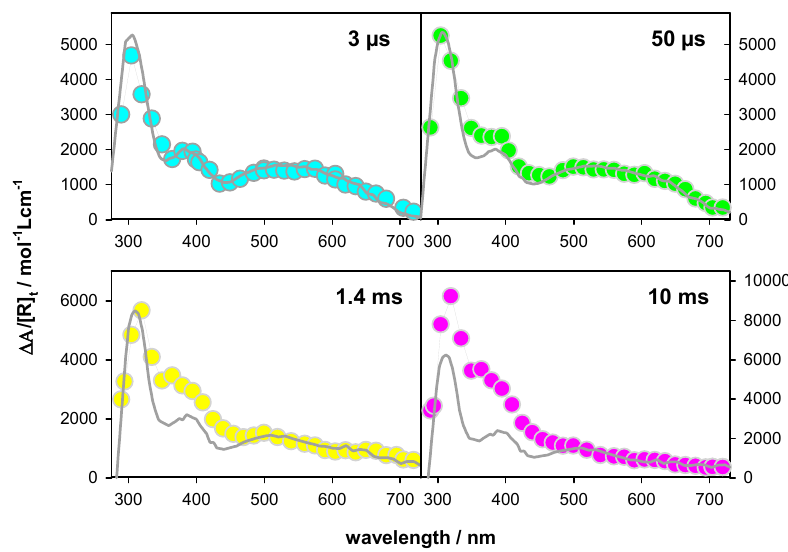
Figure 6. Transient absorption spectra determined for TEL21/K + at 3 µs, 50 µs, 1.4 ms, and 10 ms; ∆ A was divided by the total radical concentration surviving at the considered time [R] t (see Table 2). In gray: linear combinations of the monomer radical spectra considered with their ε values.